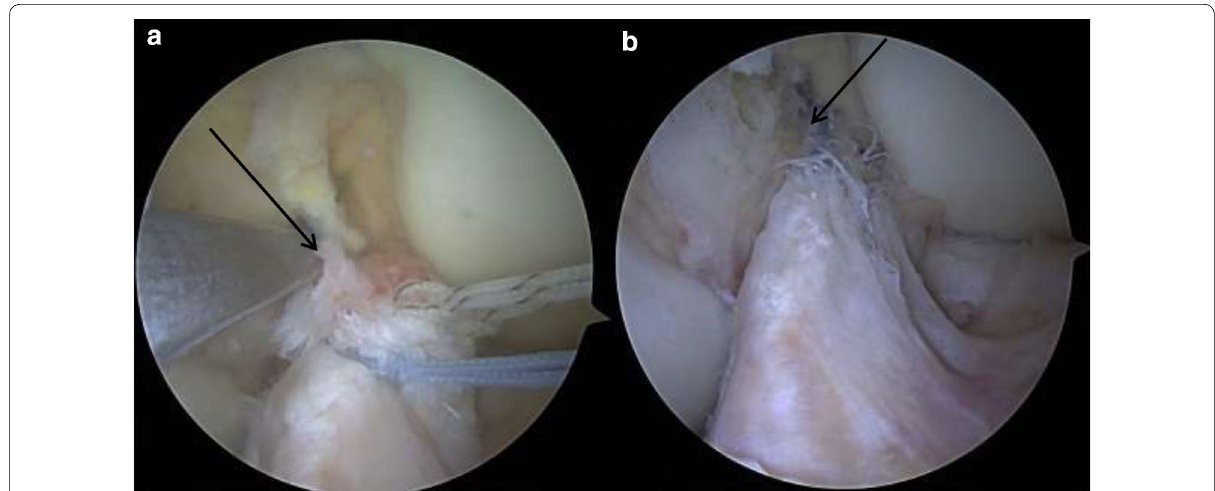
Fig. 1 Repair of a type III ACL tear. a The tibial stump was prepared with no. 2 FiberWire ® (blue) and TigerWire ® (striped). Femoral guide placed at the level of the femoral stump (black arrow). b Final arthroscopic image of a complete primary ACL repair. Black arrow indicates anatomic reapproximation of the